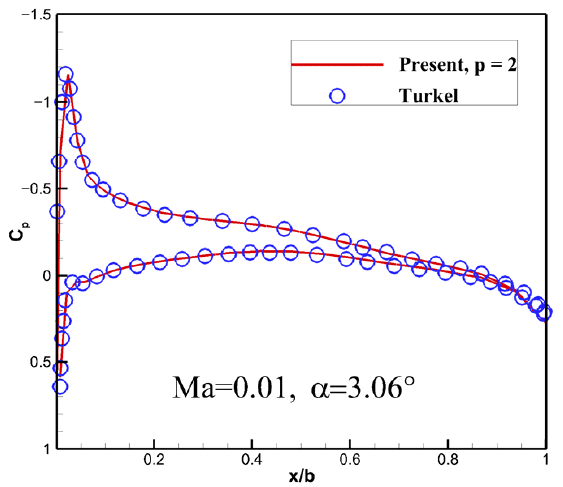
Figure 17. Distributions of surface pressure coefficients (Turkel [43]).